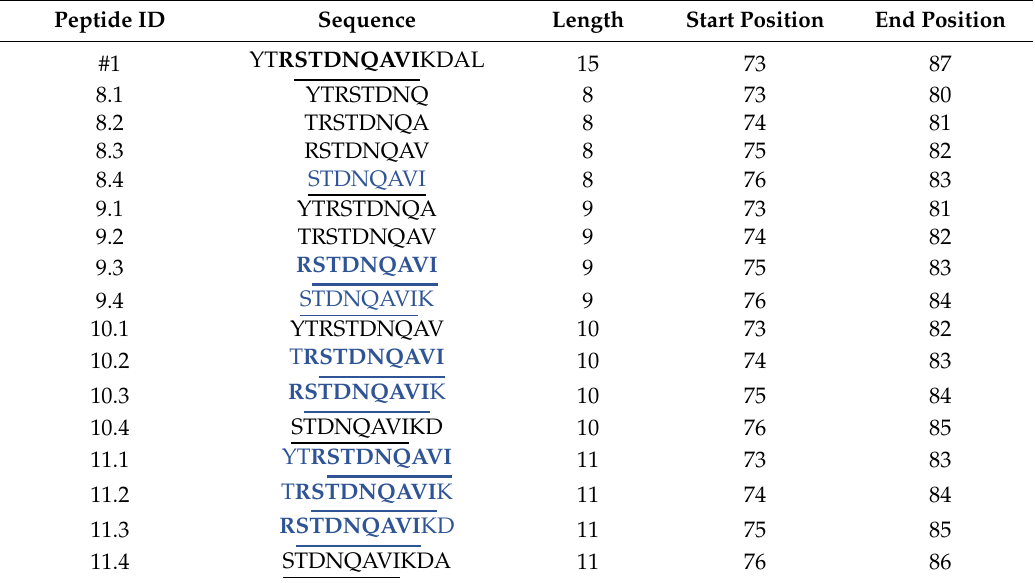
Table 1. Information on 8–11mer peptides used for H2-b-restricted epitope